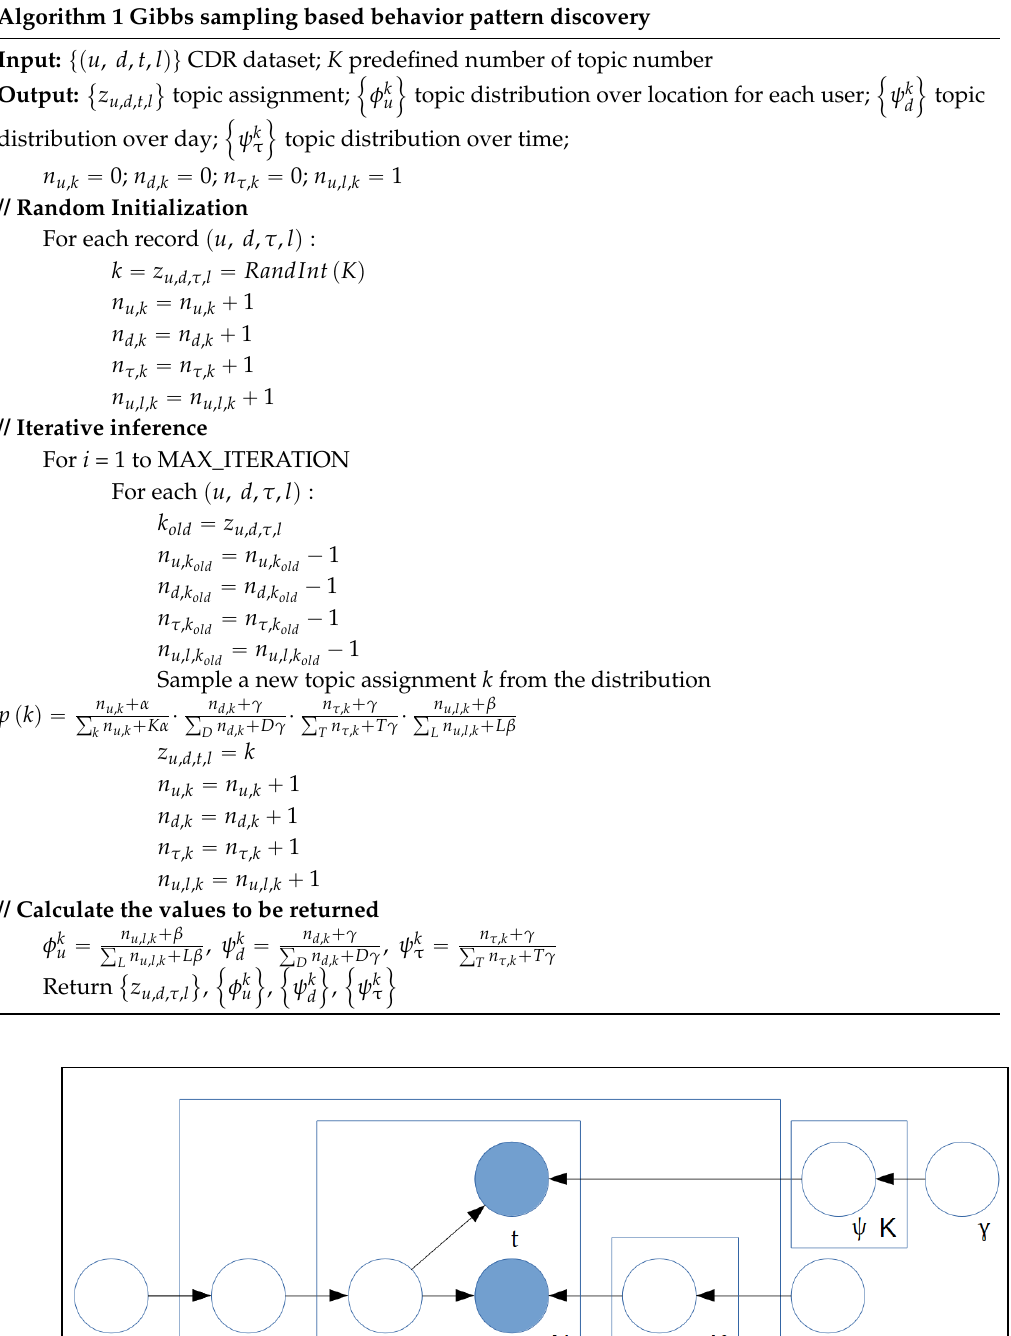
Algorithm 1 Gibbs sampling based behavior pattern discovery